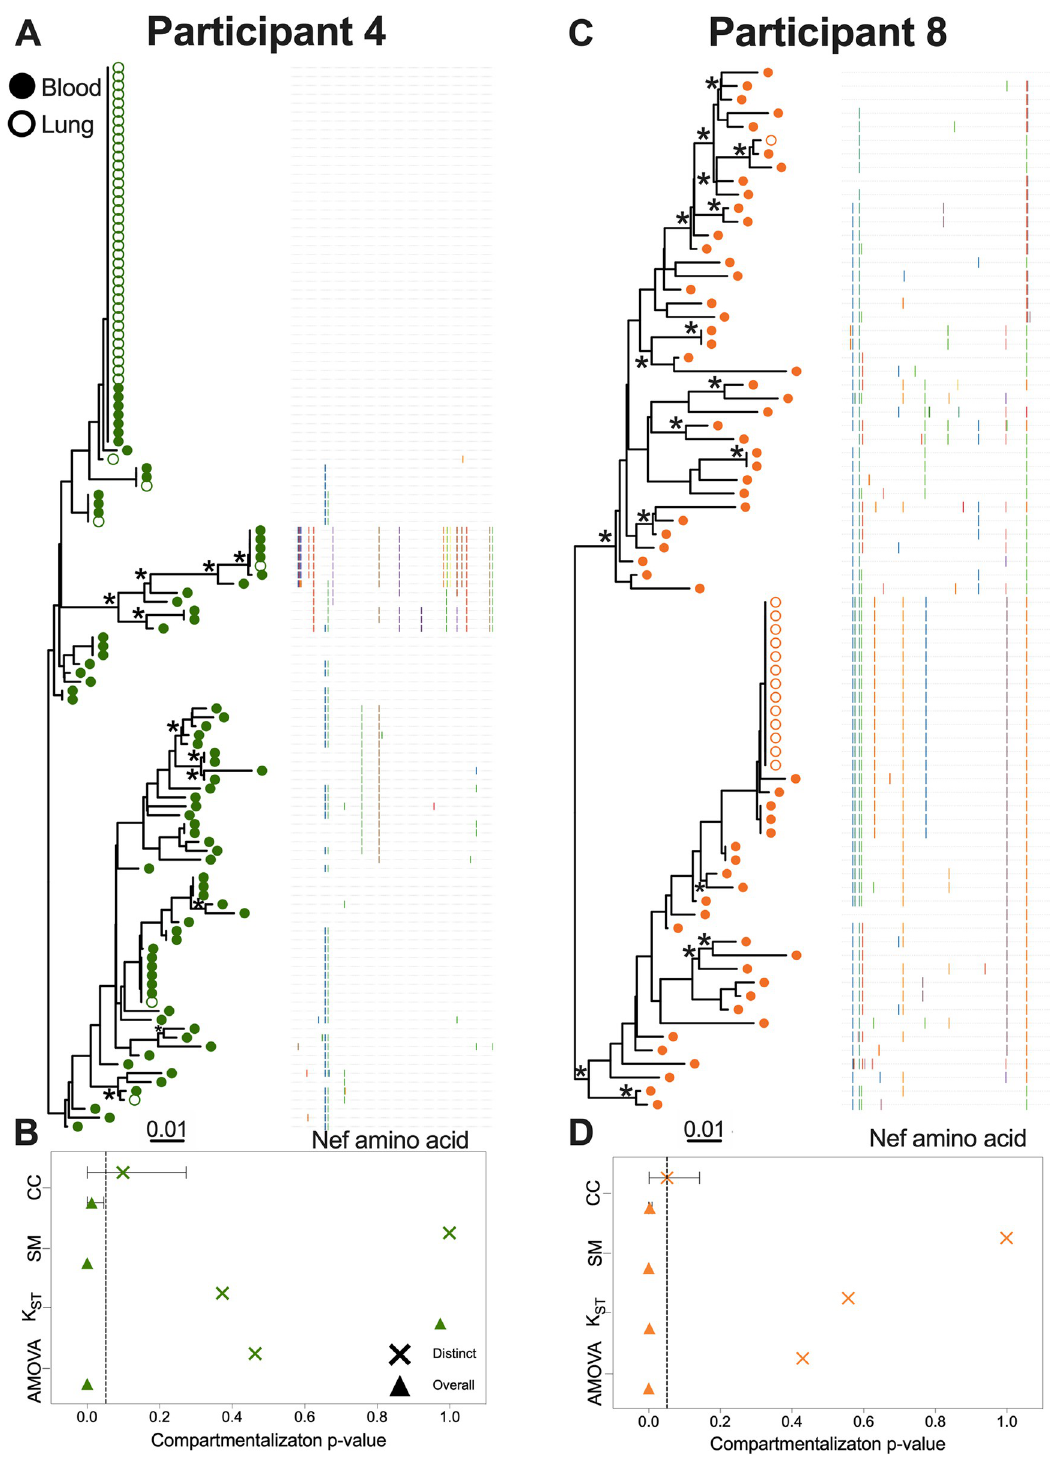
Fig 3. Within-host phylogenies and compartmentalization results for participants 4 and 8. Legend as in Fig 2.